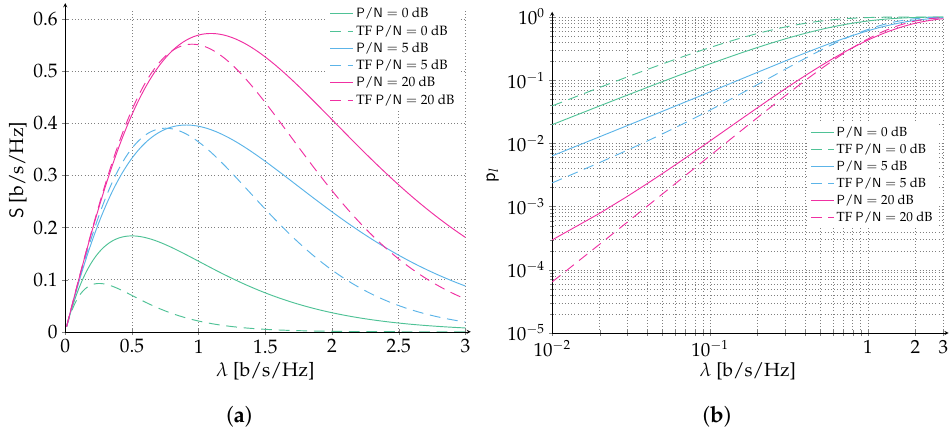
Figure 5. Performance of time and frequency ALOHA (dashed lines) compared with ALOHA (solid lines) both aided by forward error correction. The channel bandwidth to transmission bandwidth ratio is B / W = 500 for time frequency ALOHA. Data units are protected with a Gaussian codebook of rate R = 1 bits per symbol. We select the SNR in the range P / N efficiency. ( b ) Packet loss rate.